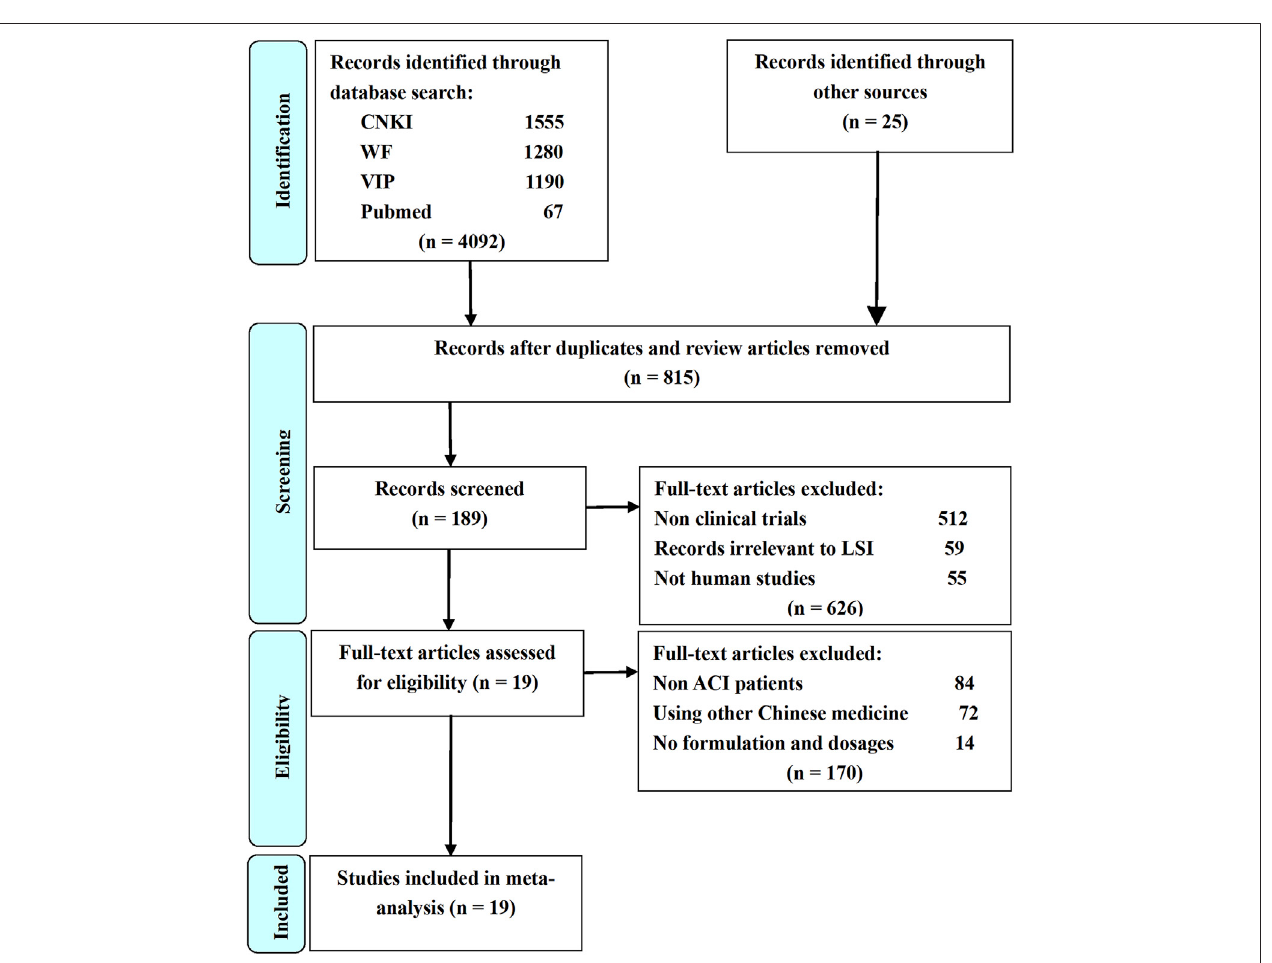
FIGURE 1 | Flow diagram of study selection process. LSI is ligustrazine injection; CNKI is China National Knowledge Infrastructure; WF is Wangfang Data; VIP is Chinese Scienti fi c Journal Database; Other sources are Medline, Chinese Biomedical Literature. Database, Cochrane Library, Embase, Google Scholar, Sino-Med, and Chinese Science Citation